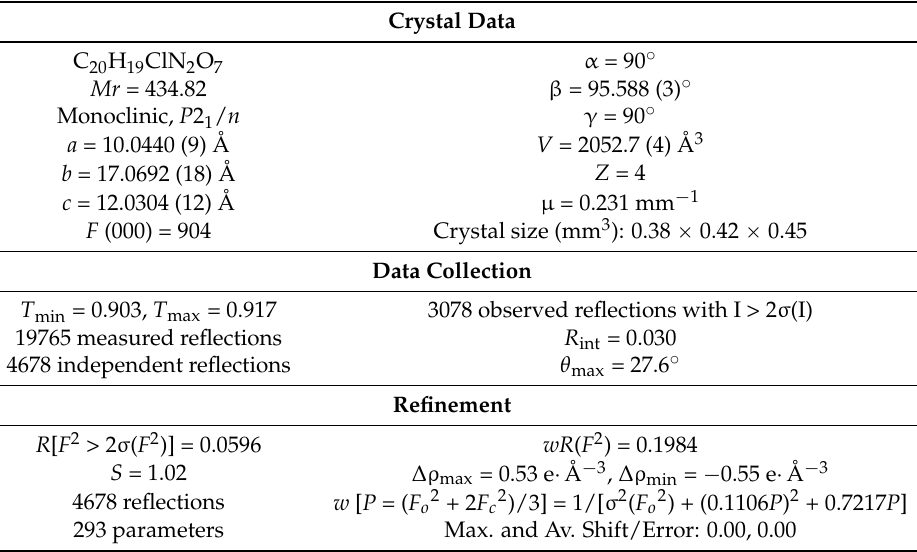
Table 1. The crystal and experimental data of compound 6b .